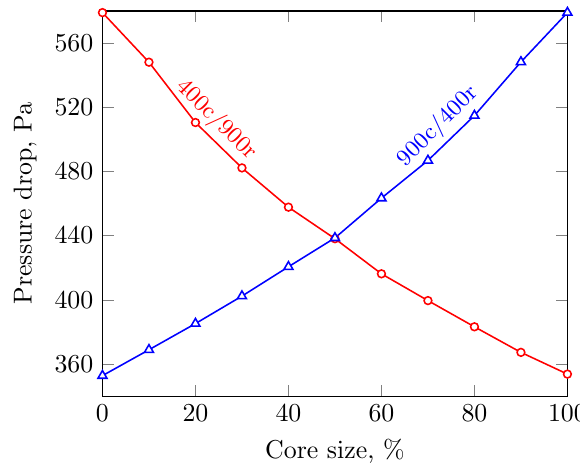
Figure 11. Pressure drop as a function of the core size.